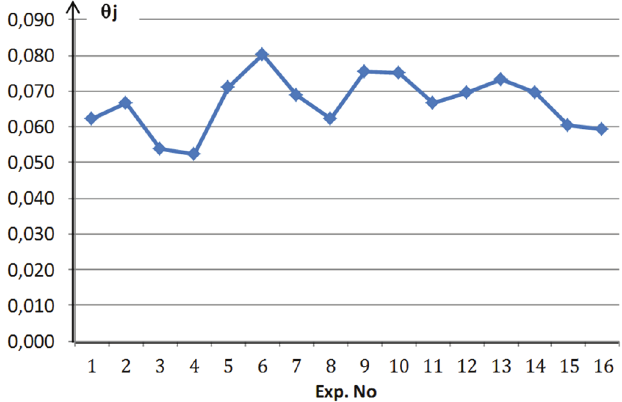
Fig. 7. Ranking PSI